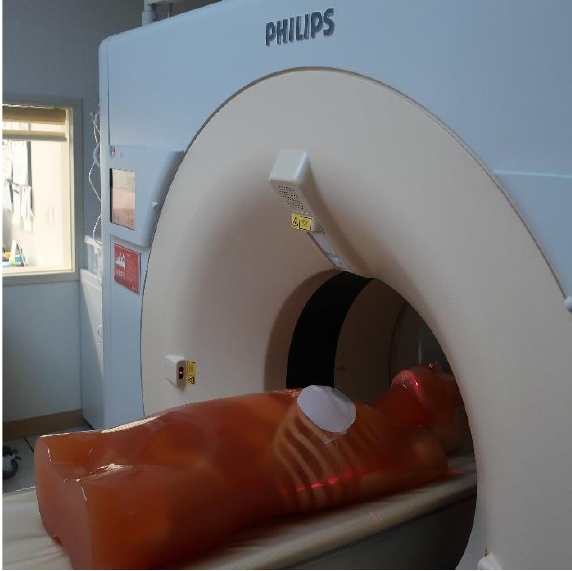
Figure 2. Computed tomography simulation. A tissue expander was attached to the left chest wall of the